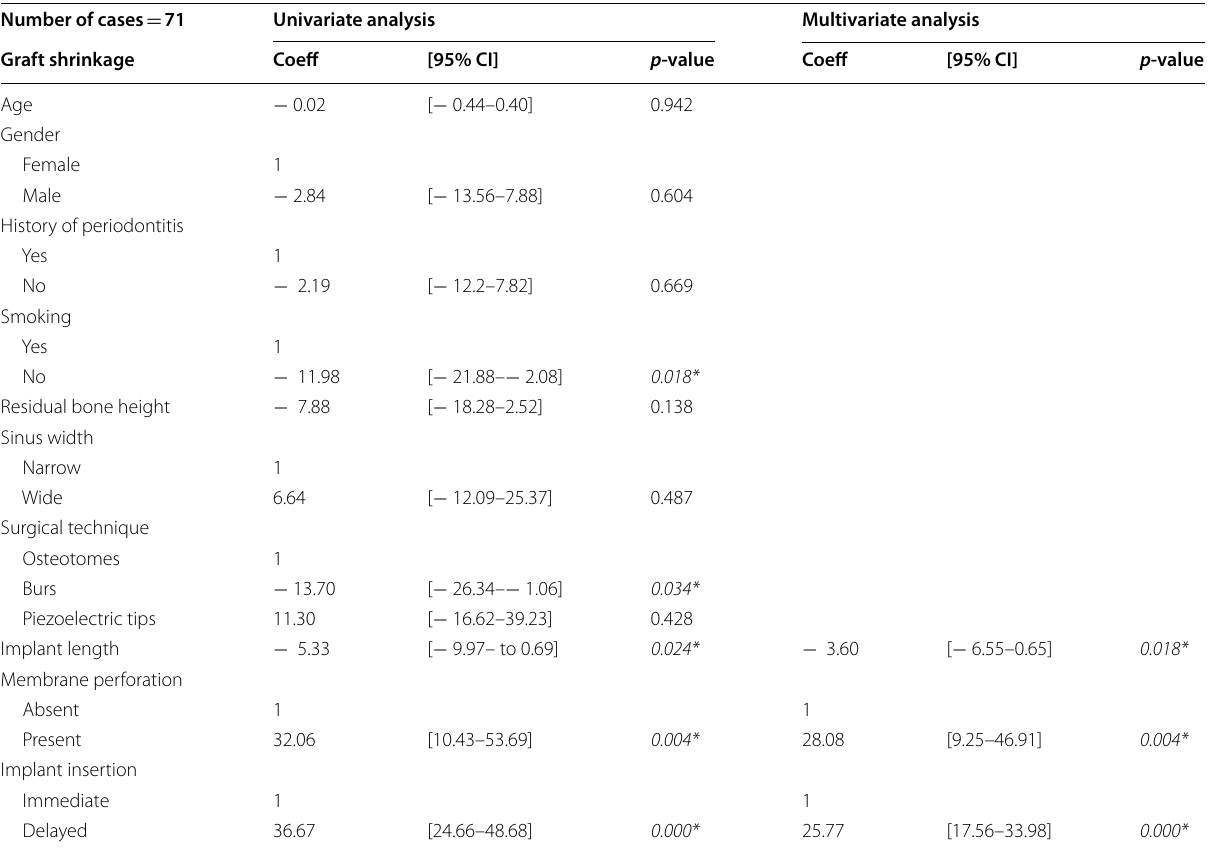
Table 3 Univariate and multivariate regression models for the outcome “Graft Shrinkage”